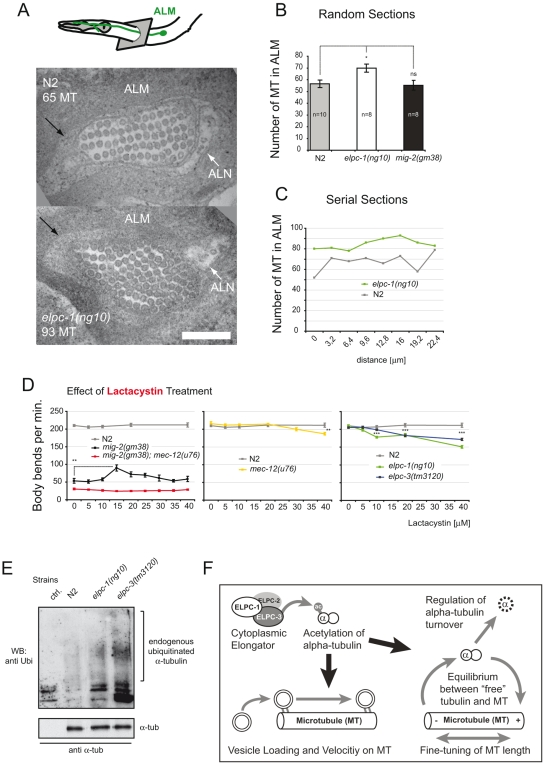
Microtubule structure and proteasome inhibition; model.(A) TEM micrograph depicting cross-sections of wt and elpc-1(ng10) ALM anterior neuronal process. ALN neuron is indicated. Black arrow points to the “ALM mantle”. Genotype and number of MT cross-sections are indicated. Bar 200 nm. (B) Number of MT cross-sections in ALM in random sections of different animals. (C) Number of MTs in serial sections of one animal to determine qualitatively variation in number along the axon. (D) Body bends per minute in response to lactacystin treatment. N2 movement is unaffected. Lactacystin can suppress the mig-2(gm38) phenotype. Suppression is dependent on mec-12/α-tubulin, since it is abolished in mec-12(u76); mig-2(gm38) background (first panel). mec-12 and elongator mutants are susceptible to high concentrations of lactacystin (second and third panel). (E) Endogenous α-tubulin from different mutant backgrounds was immunoprecipitated with anti- α-tubulin antibody and immunoblotted with an anti-Ubi antibody to detect modification of the protein by endogenous Ubi (upper panel). Lower panel: total amount of immunoprecipitated α-tubulin. (F) Model. P values: ns = not significant; *<0,05; **<0,01; ***<0,001. Error bars: SEM.